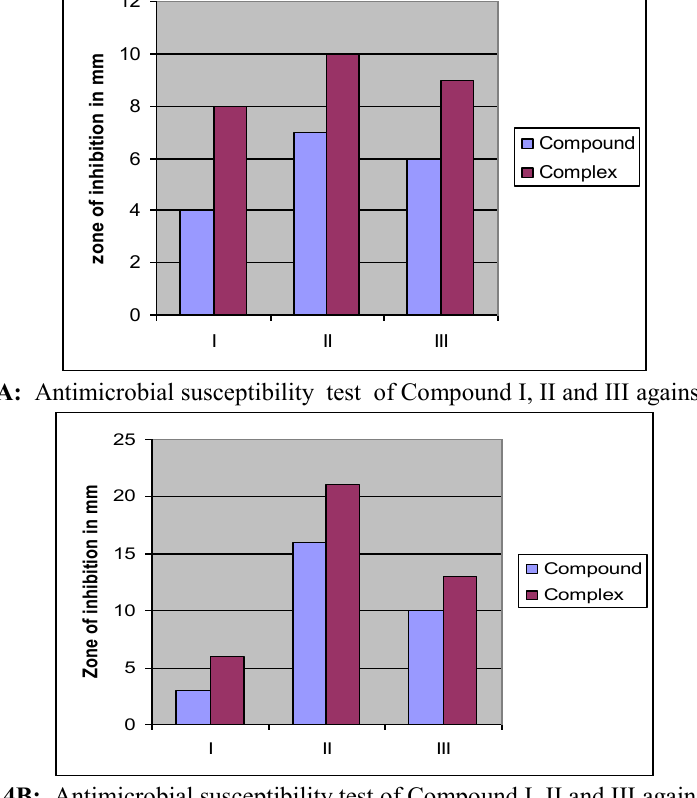
Figure 4B: Antimicrobial susceptibility test of Compound I, II and III against E.coli. The values of K for all the complexes were calculated using the relation T K = Intercept/Slope. T